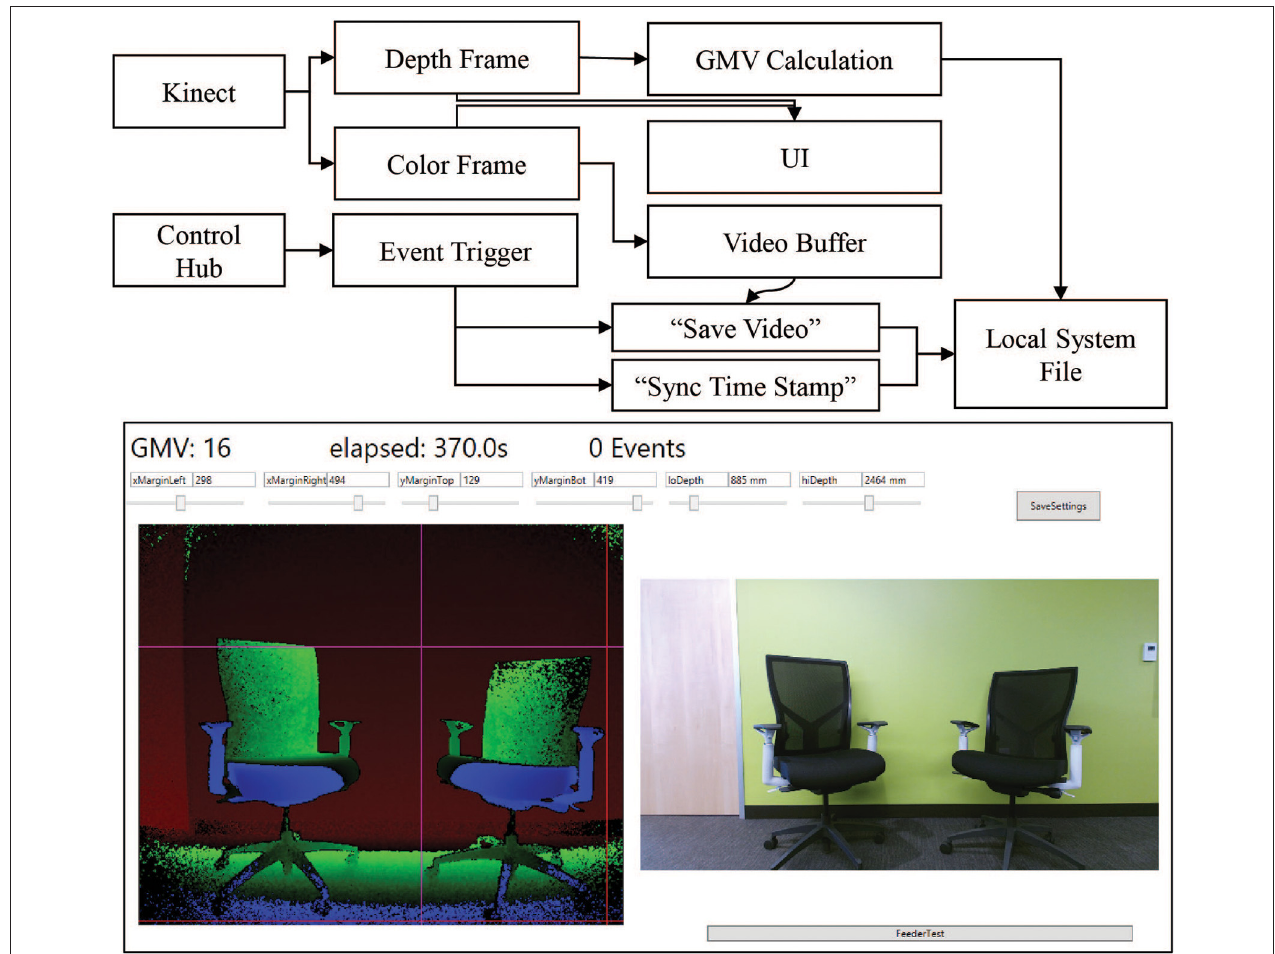
FIGURE 3 | Kinect software setup. Top. Information flow block diagram. Behavioral data is collected using a combination of the Kinect data streams and the control hub event triggers. The Kinect produces simultaneous color (bottom right) and depth value (bottom left) frames of the scene. Both frames are sent to the UI for visualization of the scene to set margin and depth cutoff values. The depth frame is also passed to the calculation module of the main program. The color frame is passed to a video buffering module which maintains a constant 8-s video. When the control hub sends an event trigger to the program, the video buffer is allowed to run 4 additional seconds before saving the video. The event trigger also triggers a time stamp value to sync the movement calculation. The calculations and the videos are saved to file in real time to prevent excess memory requirements. Bottom. The primary UI of the system displays key elements for setting up the behavior monitoring system. The current GMV value, elapsed time and event count are displayed in the top left corner. The depth (left) and color (right) streams are displayed in real time. Each margin and depth cutoff setting has its own slider for on-the-fly adjustments of the field of view for the GMV calculation. Clicking “SaveSettings” applies the settings at the start of the next session. The feeder test button sends a test pulse to the control hub to trigger the feeder and the “Save Video Test” button triggers the video saving functioning of the